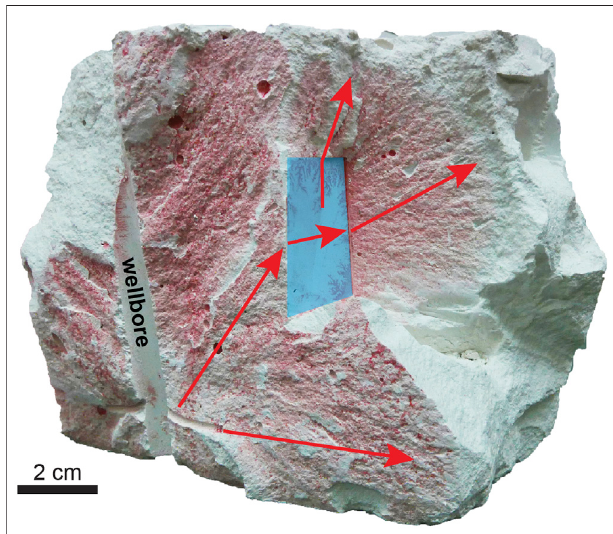
FIGURE 10 | Block 10 showing the hydraulic fracture (shown with red arrows)emanatingfromthewellboreandthenmakingadiversionstepalonga simulated natural fracture made of glass (highlighted in blue) followed by kinking and hackling off two ends.